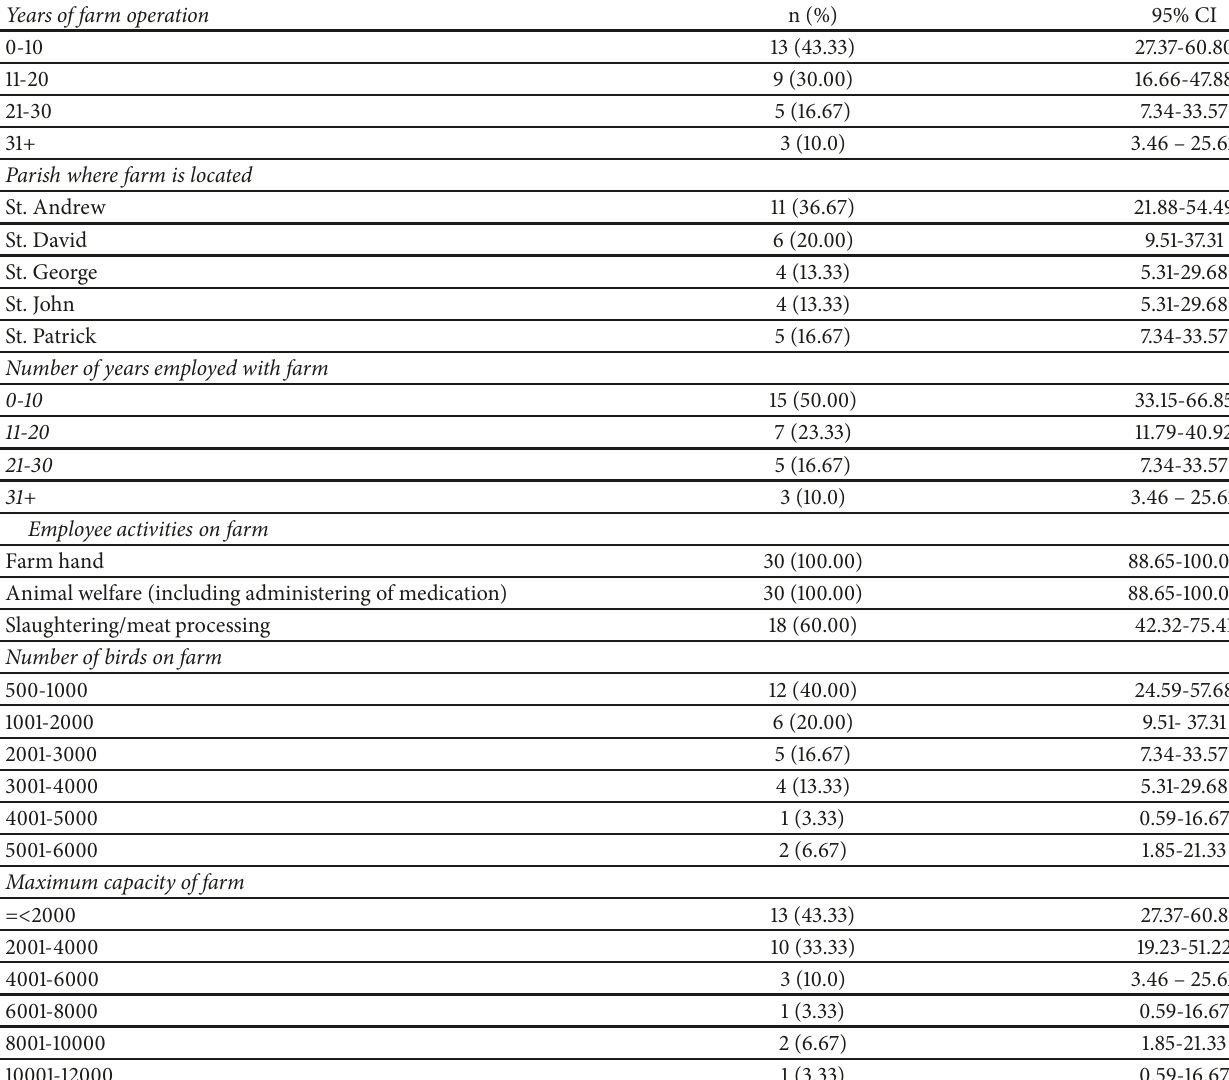
Table 1: Description of Poultry Farms and Respondents in the